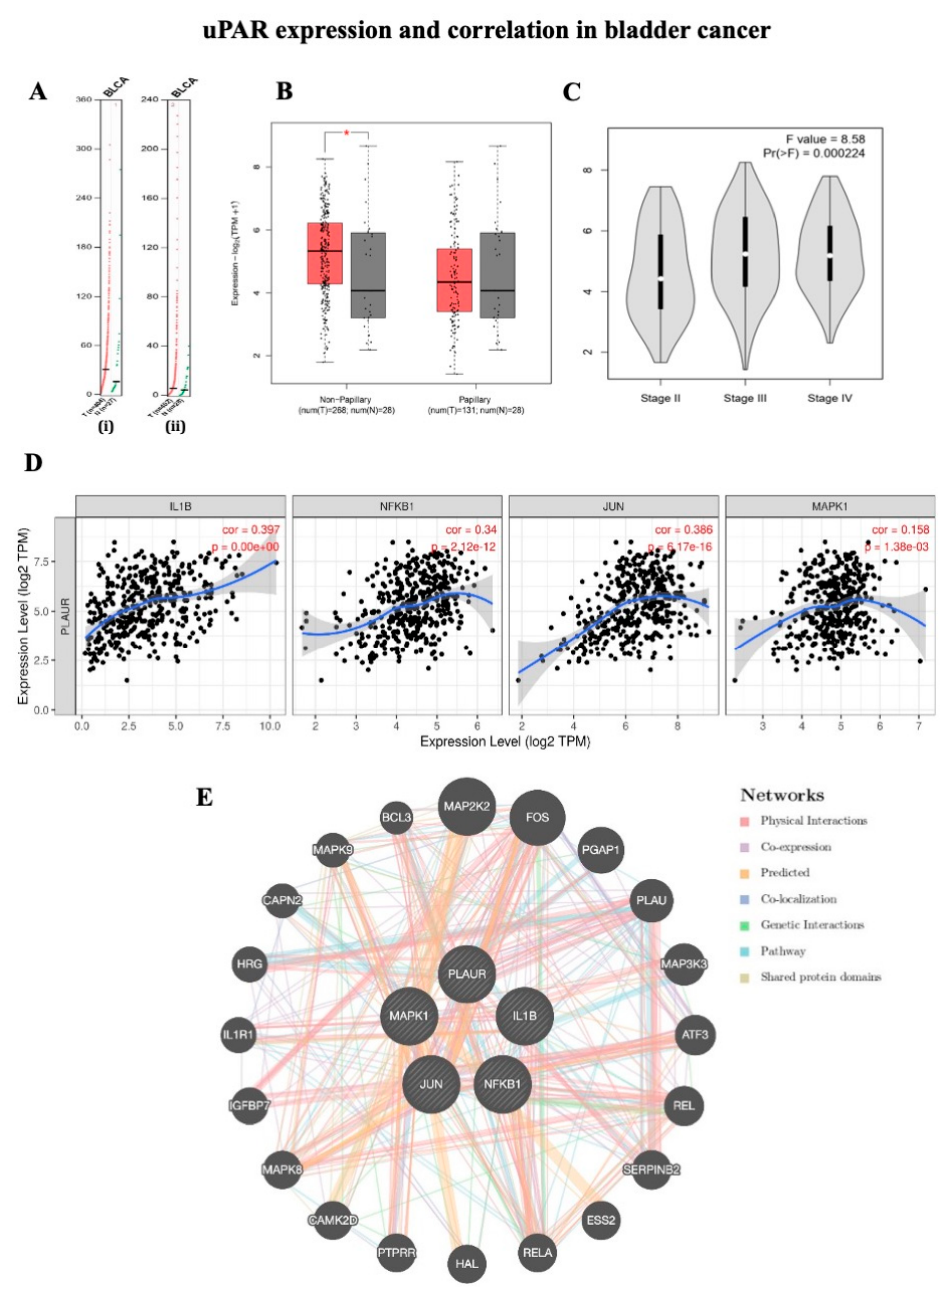
Figure 1. ( A ) Expression of uPAR (i) and IL1B (ii) in TPM scores of bladder cancer data obtained from GEPIA 2. ( B ) Expression of uPAR in non-papillary and papillary bladder cancer ( p < 0.05). ( C ) uPAR expression in various stages of bladder cancer. Expression correlation and protein interaction between IL1B, NFKB1, JUN, and MAPK1 with PLAUR in BLCA data obtained from TIMER2.0 ( p < 0.05) ( D ) and GeneMANIA ( E